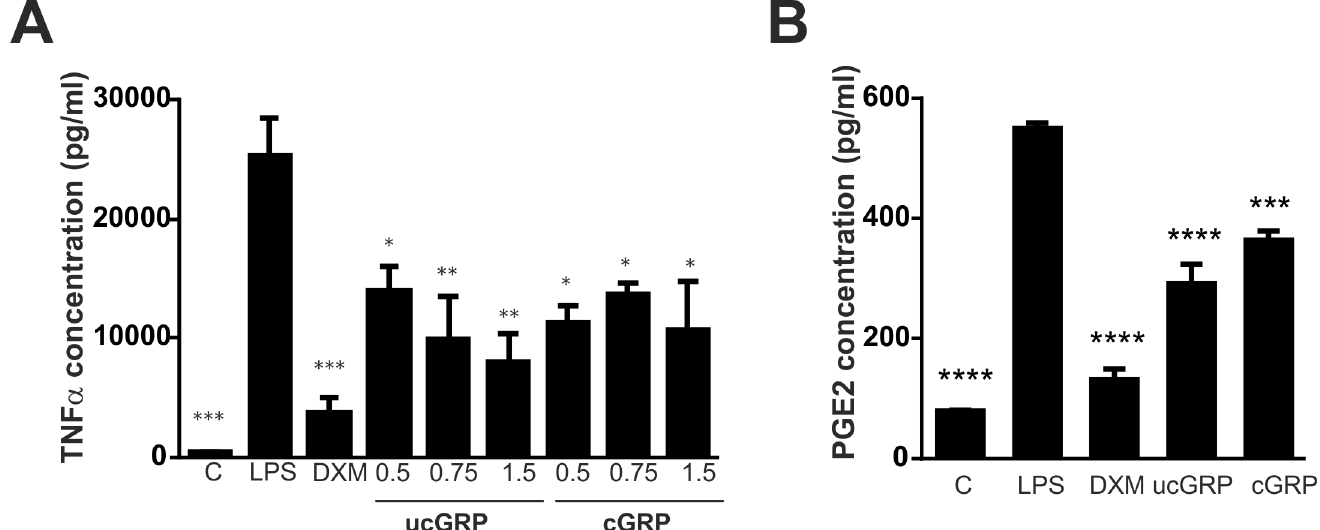
Fig 5. GRP reduces TNF α and PGE2 production in THP-1 MoM cells stimulated with LPS. (A) Differentiated THP-1 MoM cells were treated with 0.5 μ g/ml, 0.75 μ g/ml and 1.5 μ g/ml of purifiedcGRP and ucGRP proteins for 24 h, followedby exposureto 50 ng/ml LPS for additional24 h. Cells treated with 2 μ M dexamethasone (DXM) were used as a positive anti-inflammatory control, and non-stimulated cells (C) as controls to LPS stimulation. Conditioned cell culture media were collectedand used to determine TNF α accumulation by ELISA assays. Data are presented as means (n = 3) ± standarderror of triplicates of two independentexperiments. Ordinary one-wayANOVA was used and multiplecomparisons were achievedwith Dunnett’stest. Statistical significance was definedas P < = 0.05 ( * ), P < = 0.01 ( ** ), and P < = 0.001 ( *** ). (B) Differentiated THP-1 MoM cells were treated with 1.5 μ g/ml of purifiedcGRP and ucGRP proteins for 24 h and exposedto LPS as describedin (A), and PGE2 accumulation was determined in conditioned media through ELISA assays. Data are presentedas means (n = 2) ± standarderror of replicates of two independent experiments. Ordinary one-wayANOVA was used and multiple comparisons were achievedwith Dunnett’s test. Statistical significancewas definedas P < = 0.001 ( *** )and P < 0.0001( **** ).